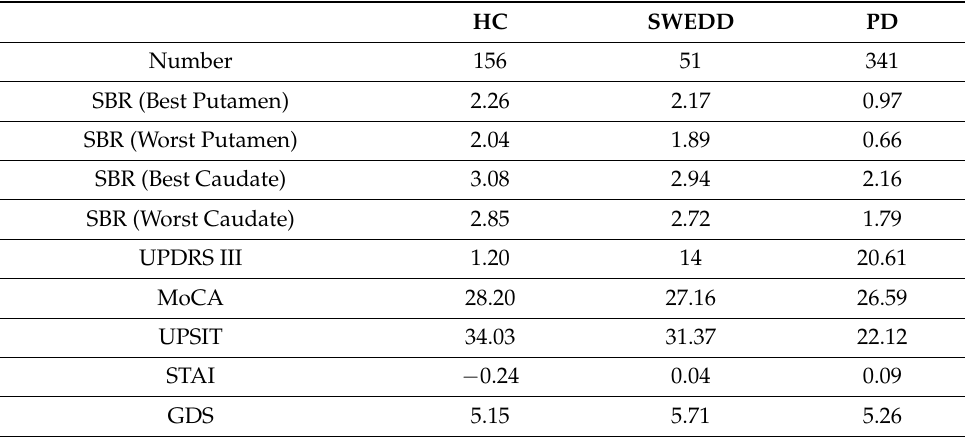
Table 2. Means of clinical and imaging features of